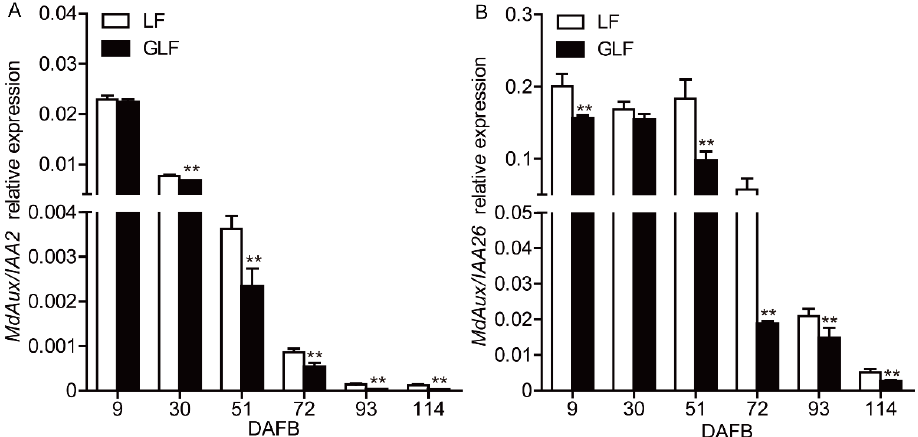
Figure 1. Expression of MdAux/IAA2 and MdAux/IAA26 in LF and GLF fruit. qRT-PCR was used to measure the relative expression of MdAux/IAA2 ( A ) and MdAux/IAA26 ( B ) in the GLF and LF fruit cortexes from 9 to 114 days after full bloom (DAFB). MdActin gene (housekeeping; EB136338) was used as endogenous control. ** Significant differences ( p < 0.05, Student’s t -test). Error bars indicate the standard deviation (SD) of the three biological replicates. LF: Longfeng; GLF: Grand Longfeng.